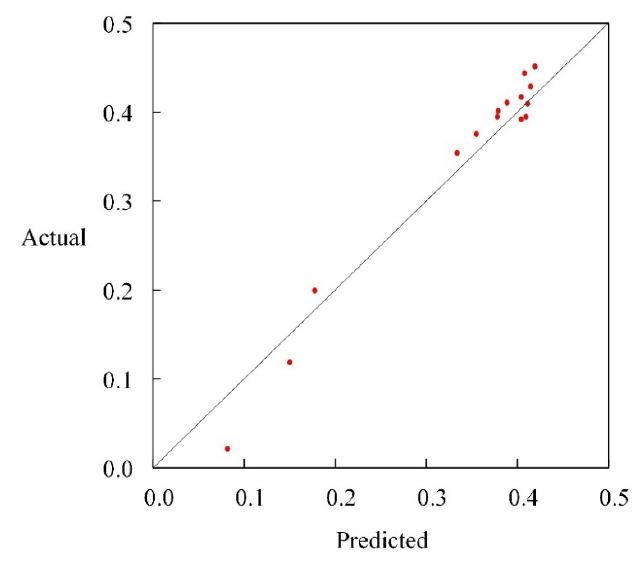
Figure 7. Error analysis of Kriging model.